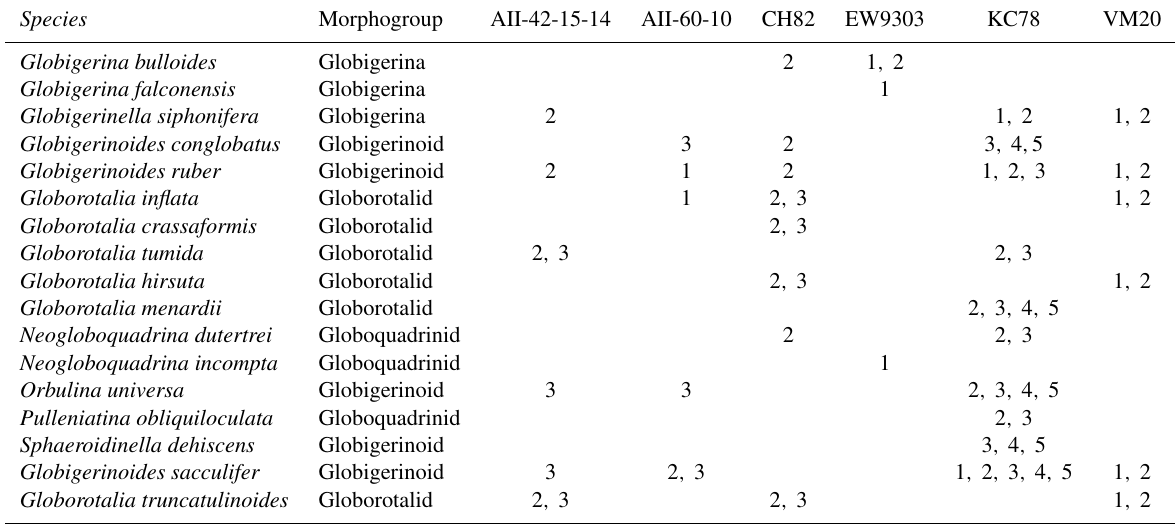
Table 1. Locality and sieve size fraction for all core-top species sampled. Marker sizes correspond with sieve size fractions (1 = 250–300µm,